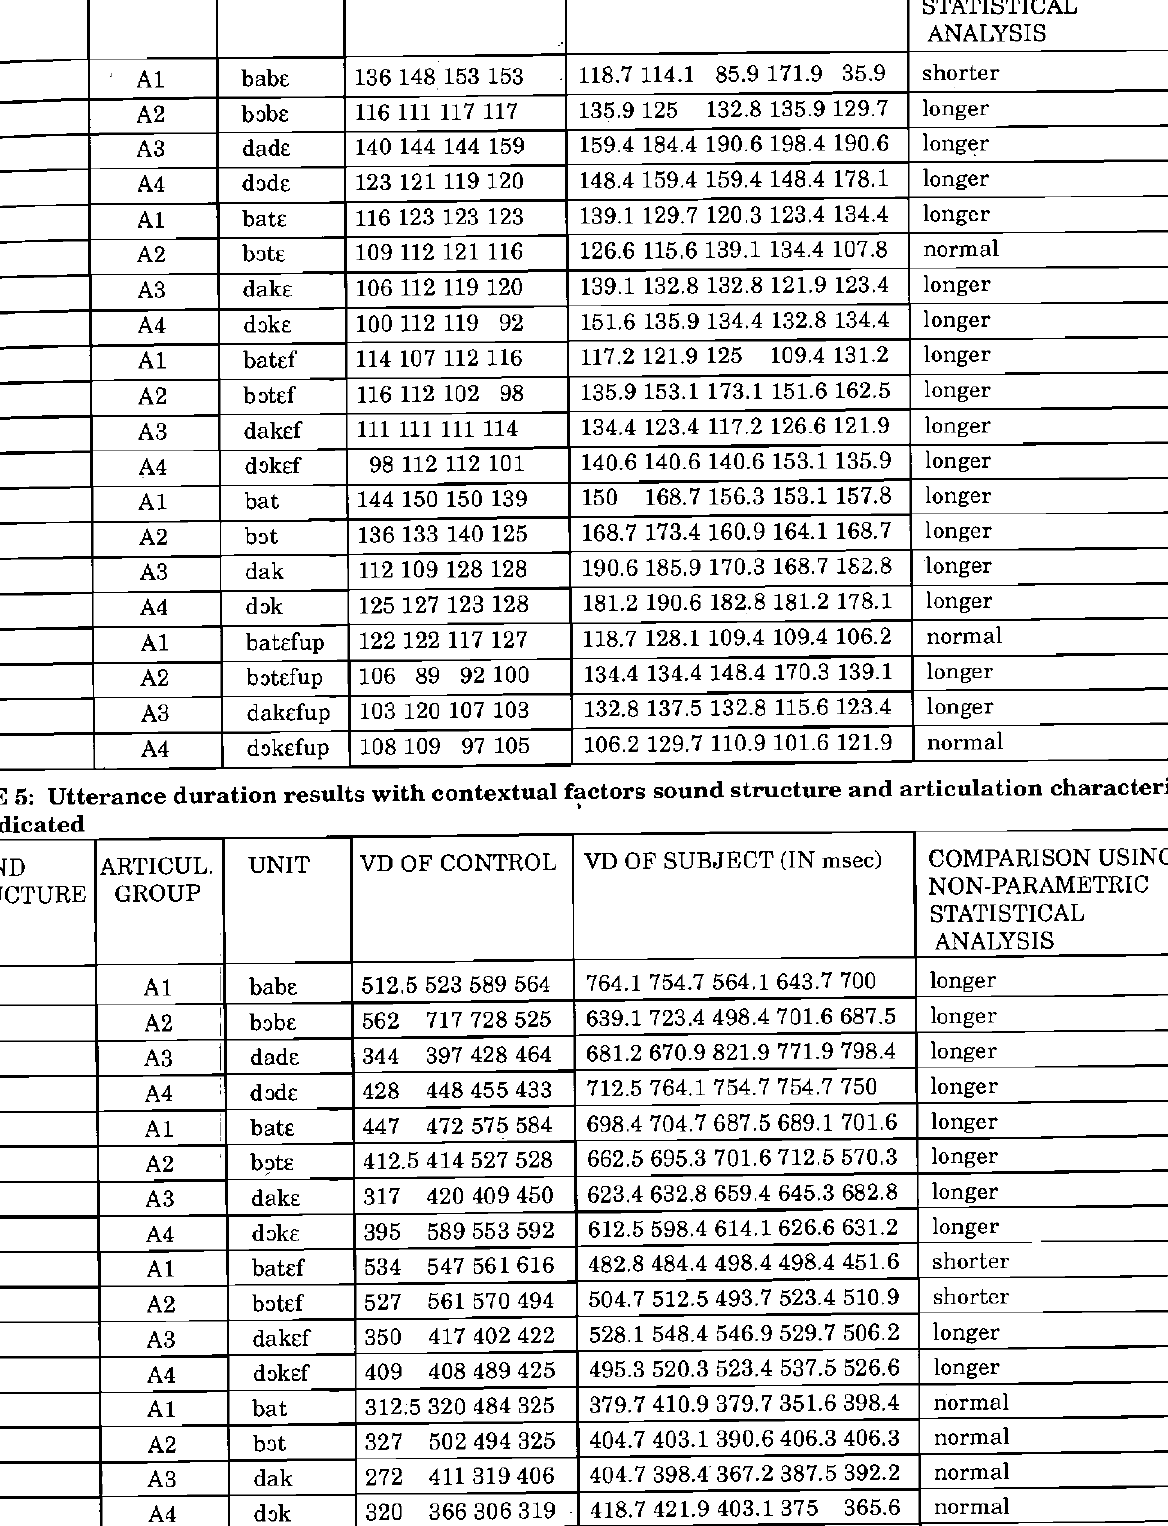
TABLE 4: Vowel duration results with contextual factors sound structure and articulation characteristics ίΠΠΙ^ι·"-" SOUND STRUCTURE